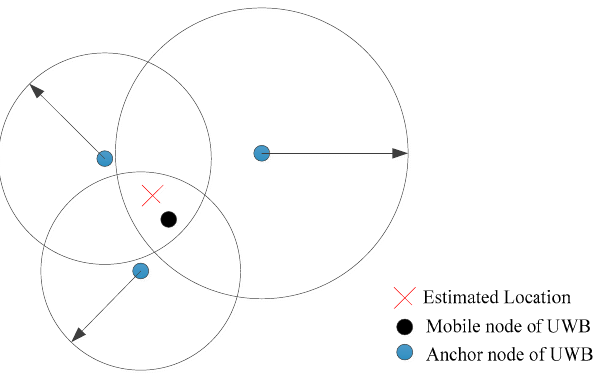
Figure 1. Illustration of UWB positioning based on ranging.